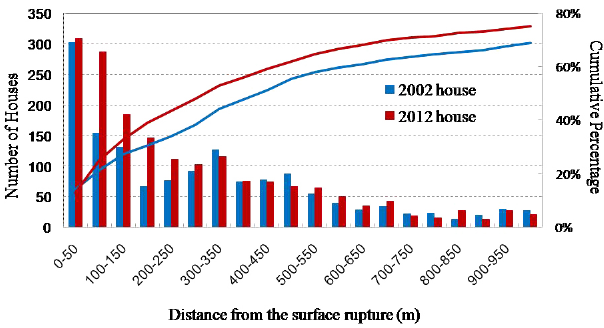
Figure 3. Houses distributions in different distance buffers from the surface rupture in the study area (bars for numbers of houses and curves for cumulative percentage of